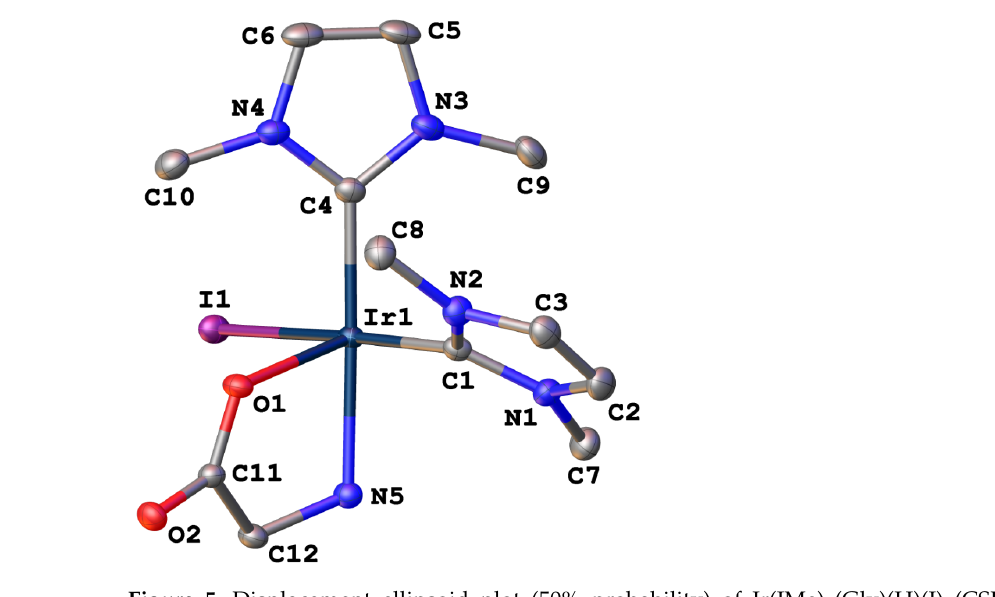
Figure 5. Displacement ellipsoid plot (50% probability) of Ir(IMe) 2 (Gly)(H)(I) (CSD 2062242). The complex crystallized in the triclinic space group P ¯1. Hydrogen atoms are omitted for clarity. Table 2. Selected bond lengths and angles from the crystal structure of Ir(IMe) 2 (Gly)(H)(I).